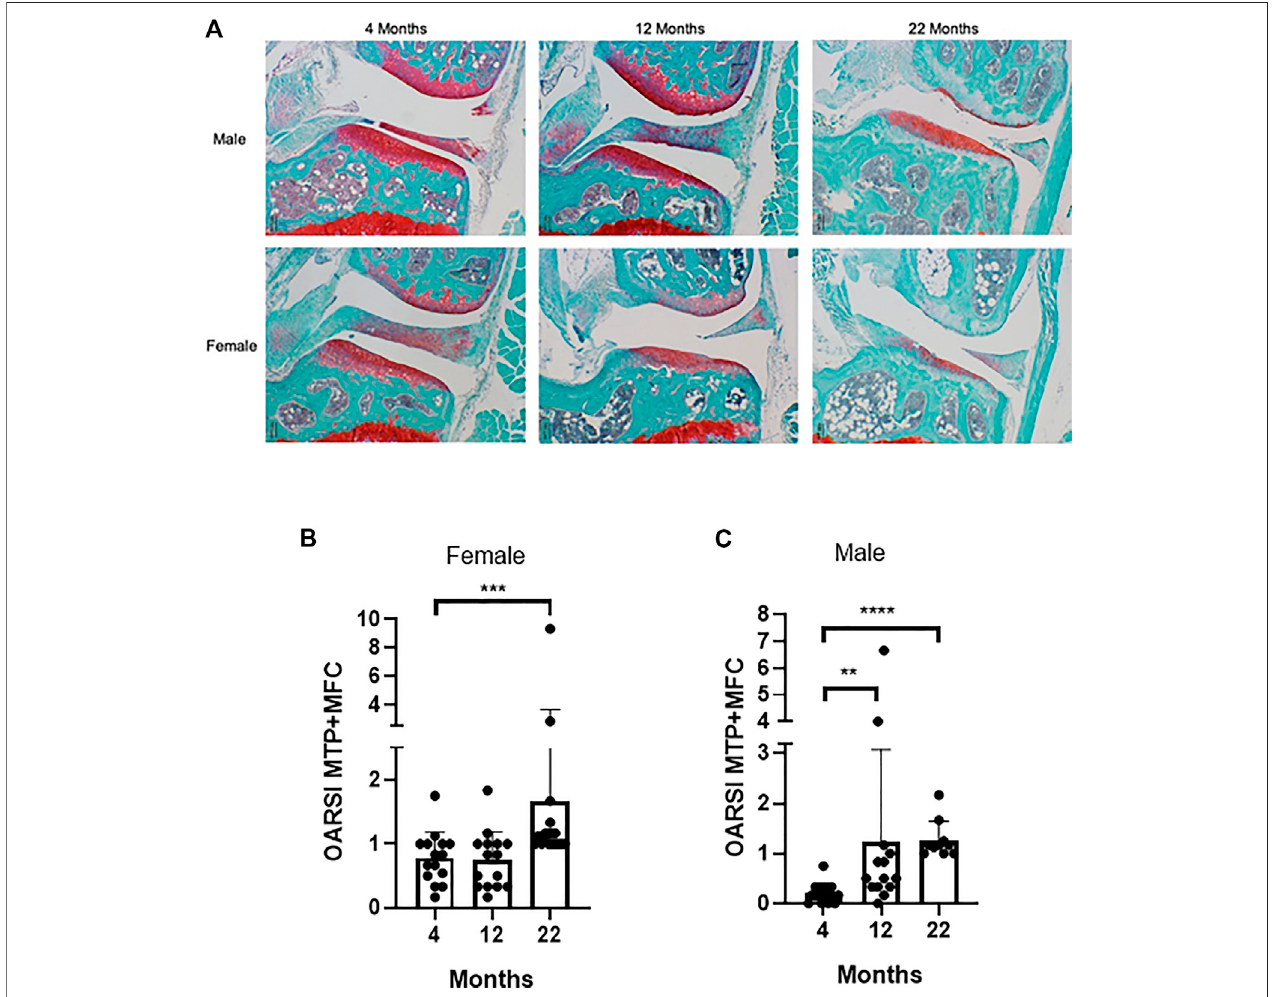
FIGURE 2 | UM-HET3 mice develop joint pathology with age (A) Representative examples of joint pathology in male and female UM-HET3 mice at different ages; (B) Cartilage changes in female mice at 4 months ( n = 16), 12 months ( n = 15) and 22 months ( n = 18); (C) Cartilage changes in male mice at 4 ( n = 17), 12 ( n = 14) and ( n = 10) 22 months. Values are the mean ± SD ofOARSI score for the medial tibia plateau (MTP) plus the medial femoral condyle (MFC). Datawere analysed by Kruskal- Wallis test and Dunn ’ s multiple comparisons test, ** p < .01, *** p < .001, **** p < .0001.